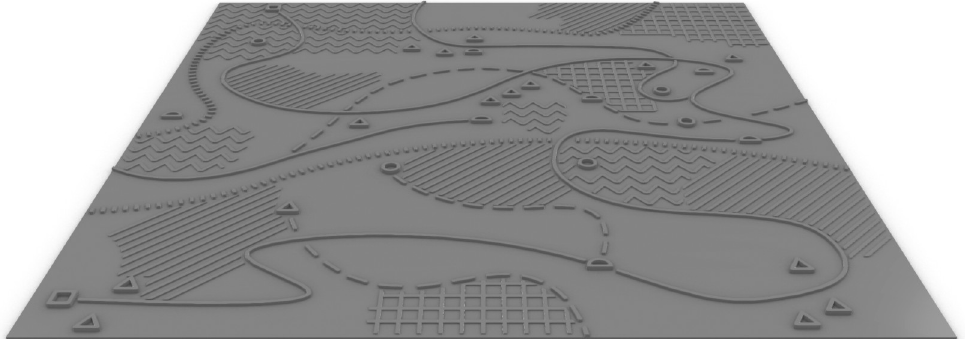
Fig 5. Digital 3D Model of one of the stimuli